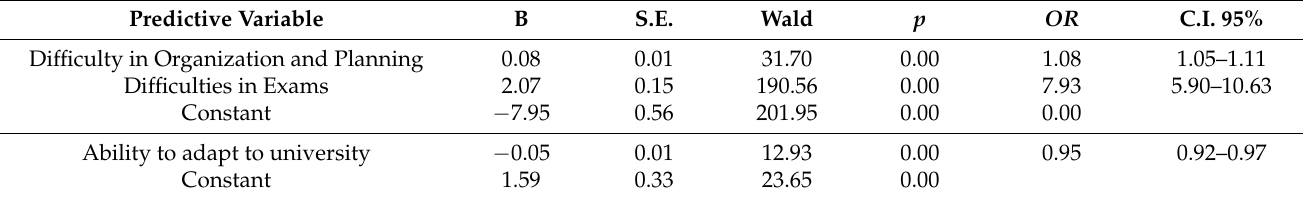
Table 4. Results derived from binary logistic regression for the probability of being a cybervictimized bully. Predictive Variable B S.E. Wald p OR C.I. 95% Difficulty in Organization and